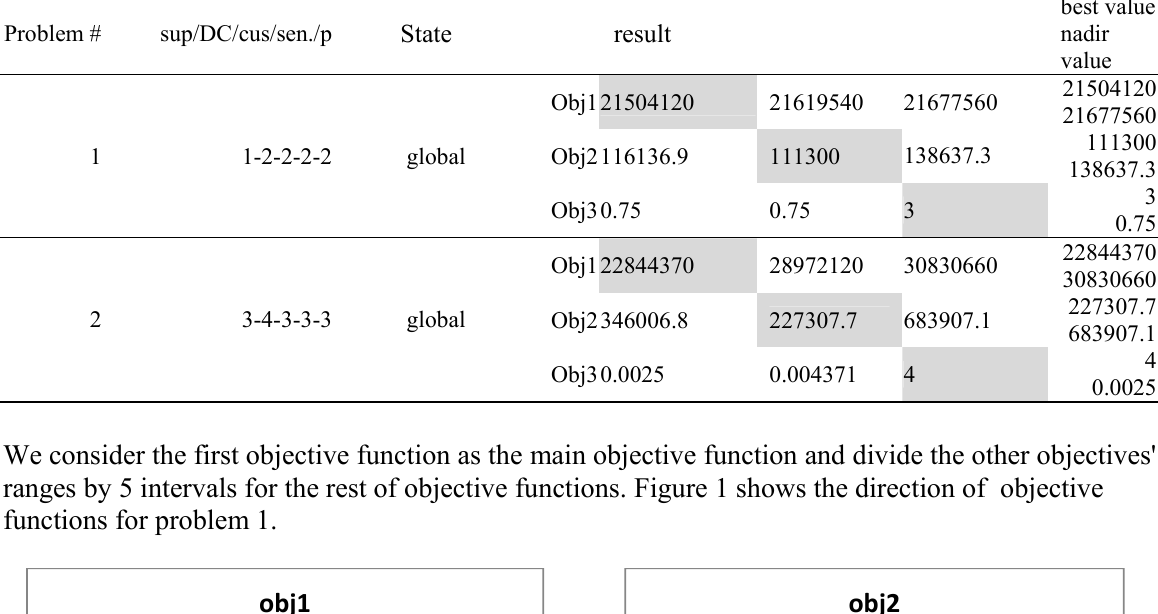
Result of lingo